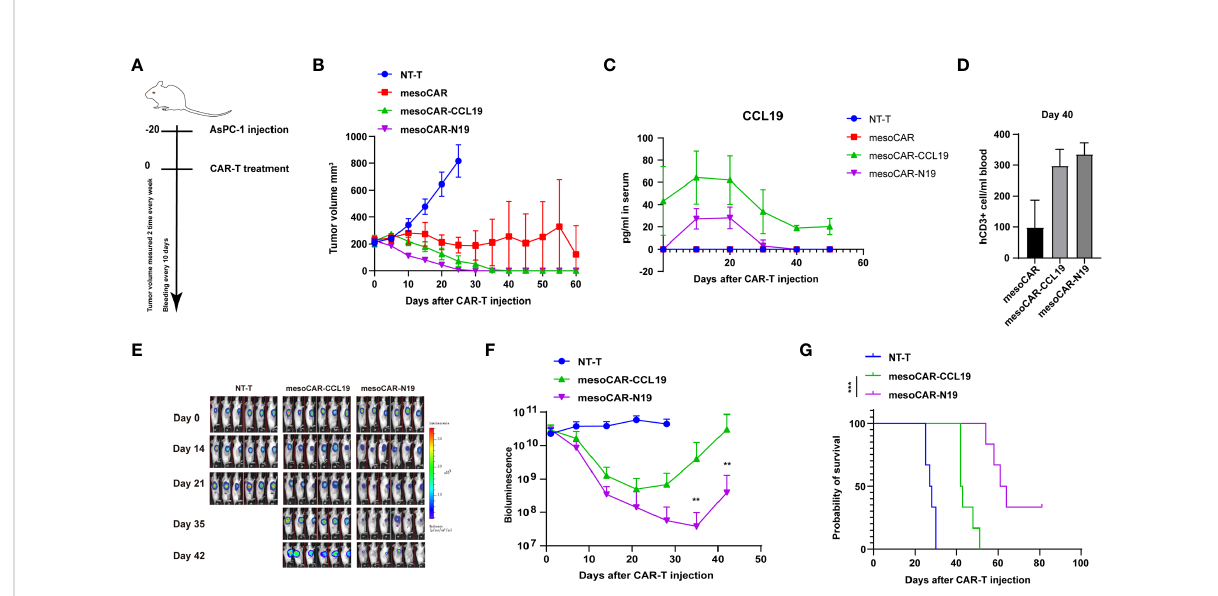
FIGURE 4 Analysis of chimeric antigen receptor T (CAR-T) cell function in vivo . (A) Schematic diagram of the experimental design; (B) Tumor volume measurements; (C) Changes in C-C motif chemokine ligand 19 levels in the mouse plasma as measured using ELISA; (D) Detection of CD3- positve cells using fl ow cytometry on day 40. (E) Images of tumors after CAR-T treatment; (F) Bioluminescence images and luminescence curve; (G) Mouse survival presented as Kaplan-Meier curves. In (B, C) , the error bars represent the mean ± SD whereas in (F) the error bars represent the means± standard error of the mean (n =6).